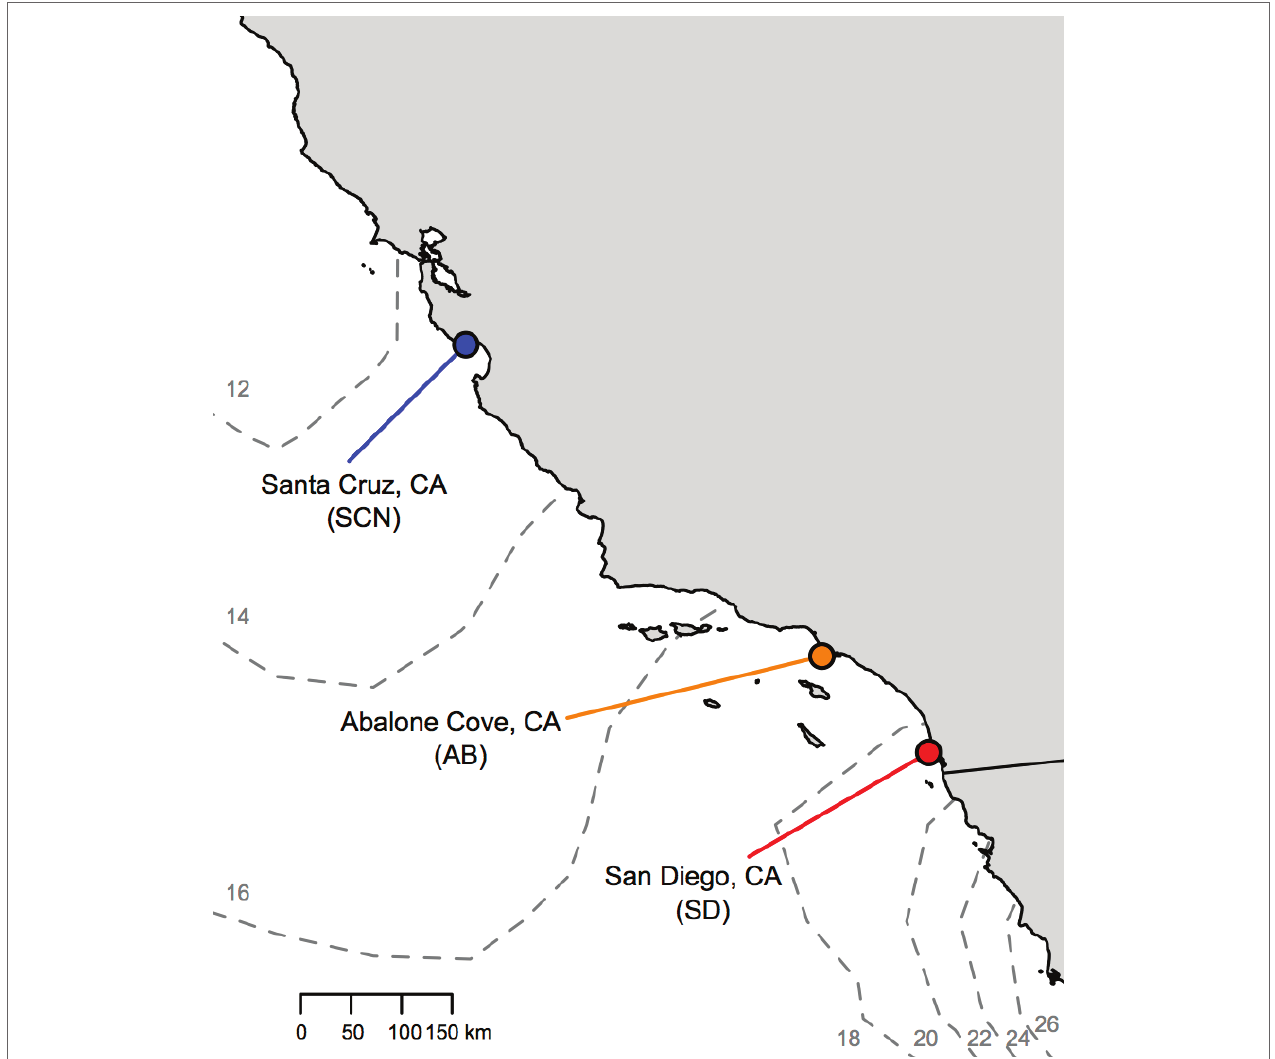
FIGURE 1 | Locations of T. californicus collection sites along the coast of California (gray = land; white = Pacific Ocean). Sites are indicated by colored circles [red = San Diego (SD); orange = Abalone Cove (AB); blue = Santa Cruz (SCN)]. Dashed gray lines outline contours of average sea surface temperatures from the first week of July 2017 with temperature in degrees Celsius indicated by small gray numbers (obtained from: http://www.cpc.ncep.noaa.gov/products/GIS/